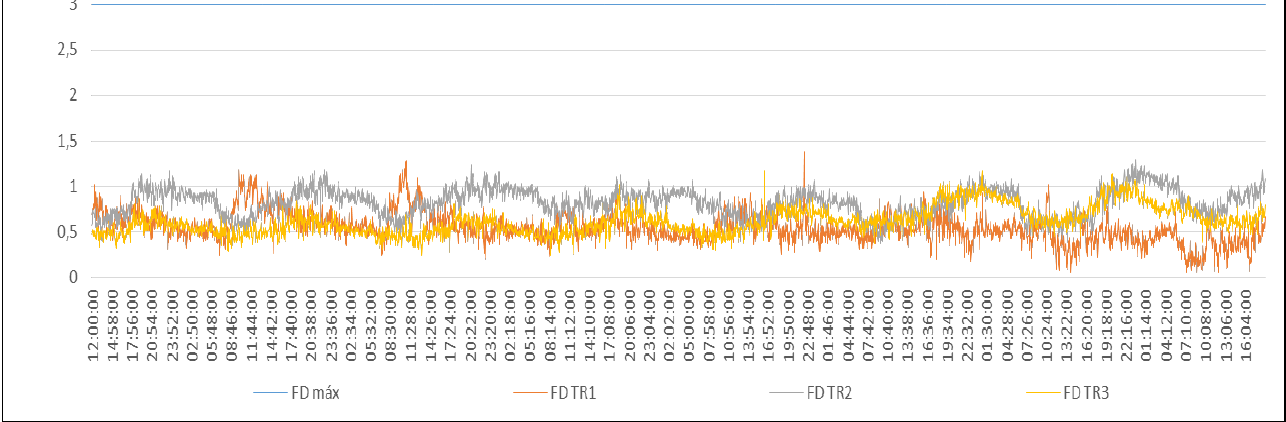
Figure 3: Unbalance factor indicator